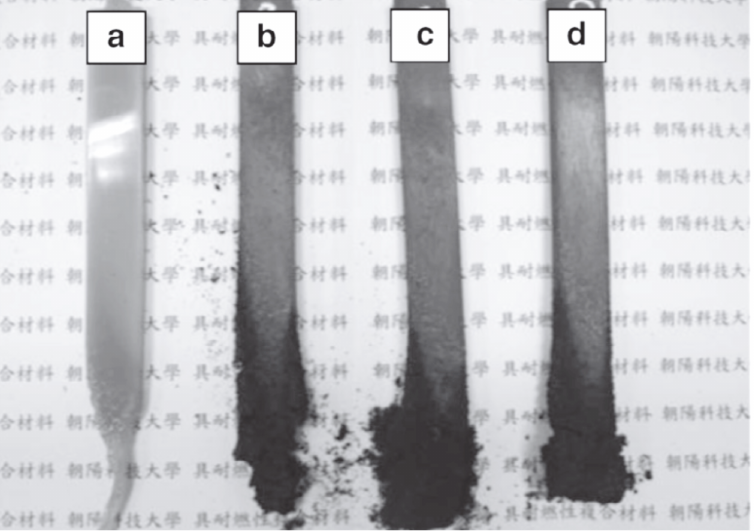
Figure 7. Photographic images of char residues after combustion of ( a ) neat PLA ( b ) PLA/13EG-4APP/MCF/MOMMT, ( c ) PLA/23EG-4APP/MCF/MOMMT, and ( d ) PLA/13EG 8APP/MCF/MOMMT composites. Reproduced from ref.